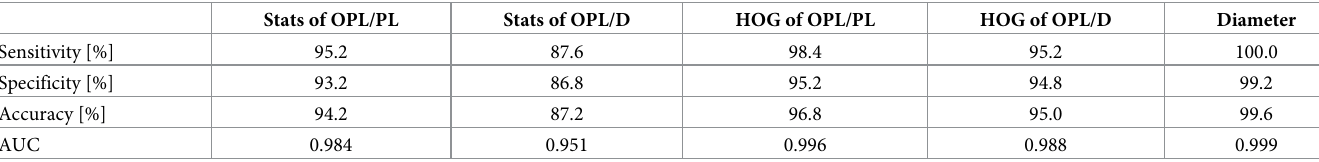
Table 3. Performance of the classifications on the basis of various